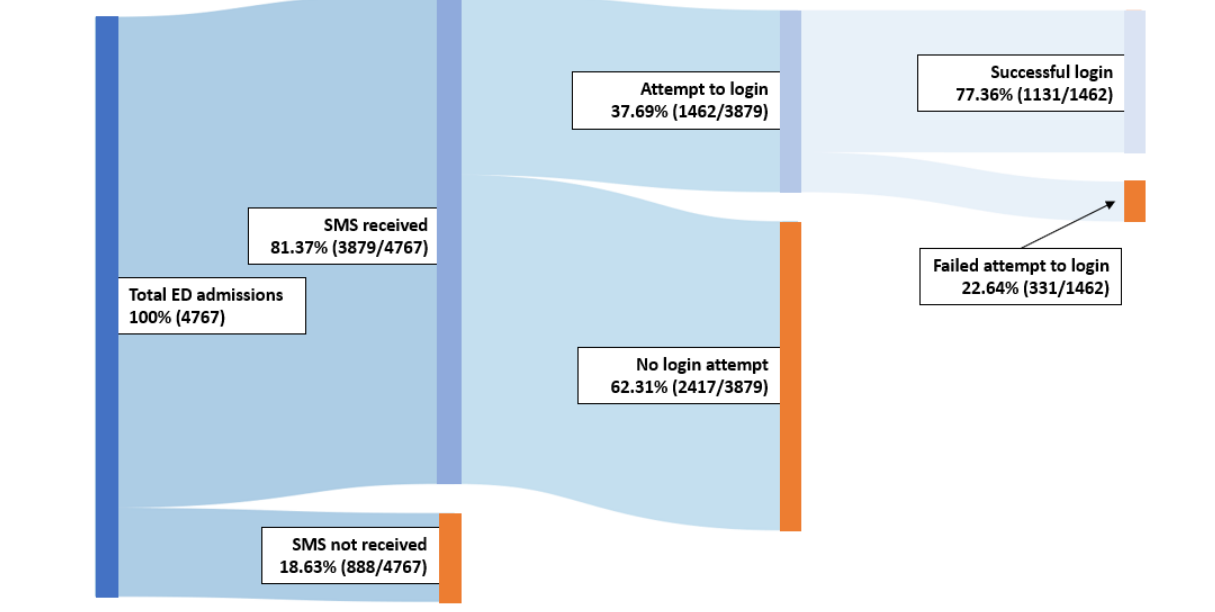
Figure 7. System adoption in first 3 months of deployment (08-10/2018). ED: emergency